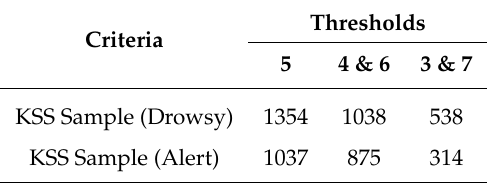
Figure 4. Receiver operating characteristic (ROC) curves for the autoregressive (AR) model support vector machine (SVM) and step-wise linear discriminant analysis (SWLDA) SVM. Table 1. The number of KSS samples labeled as drowsy and alert using three different